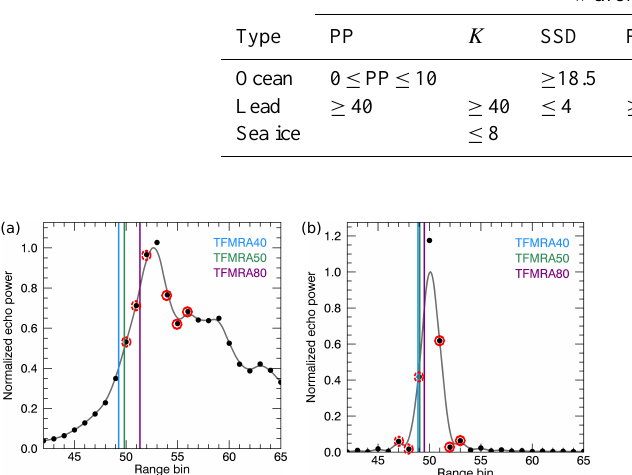
Figure 3. Typical CryoSat-2 waveforms for sea ice (a) and leads (b) . The fitted waveform (grey) is a result of linear interpola- tion and smoothing of the original CryoSat-2 waveform (black dots). The coloured vertical lines represent the different applied TFMRA (threshold first-maximum retracker algorithm) thresholds in this study: 40% (TFMRA40), 50% (TFMRA50) and 80% (TFMRA80). Red circles mark the range bins that are considered for the “left-hand” (dotted) and “right-hand” peakiness